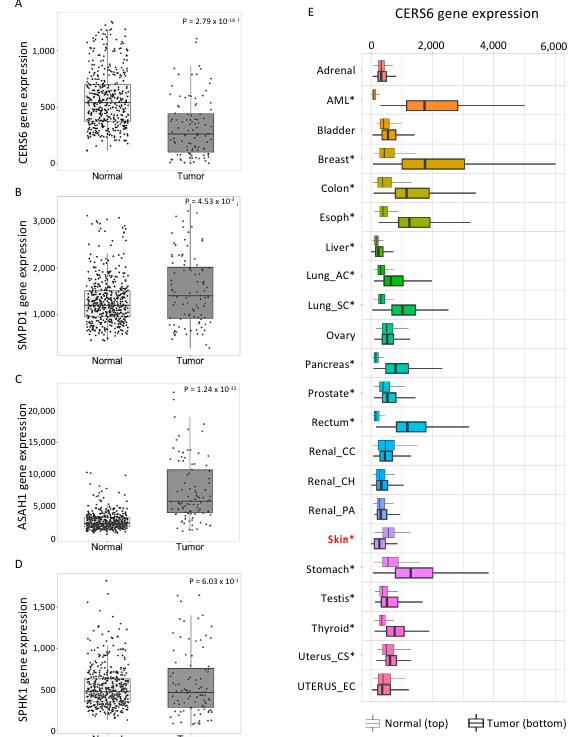
Figure 6. Ceramide metabolism enzyme expression is altered in human skin cancer. The web platform TNMplot was used to evaluate mRNA levels of ceramide metabolism enzymes in human non- cancerous normal skin tissue (normal, n = 474) and cutaneous melanoma (tumor, n = 103). ( A – D ) CERS6 ( A ), SMPD1 ( B ), ASAH1 ( C ), and SPHK1 ( D ) gene levels were analyzed between Normal and Tumor groups. ( E ) Pan-cancer analysis shows CERS6 gene expressions between Normal ( top ) and Tumor ( bottom ) in 22 cancer tissue types. Lung_AC, lung adenocarcinoma; Lung_SC, lung squa- mous cell carcinoma; Renal_CC, kidney renal clear cell carcinoma; Renal_CH, kidney chromophobe; Renal_PA, kidney renal papillary cell carcinoma; Uterus_CS, uterine carcinosarcoma; Uterus_EC, uterine corpus endometrial carcinoma. Significant differences were analyzed by Mann–Whitney U test and are denoted with an asterisk. * p < 0.01 vs. paired normal control. Font and color were mod- ified for better readability of the original graphs obtained from TNM plot.com. Skin cancer is marked with red for better visualization. 4. Discussion Identification of the molecular changes within tumors that are induced by exercise is critical to maximizing the potential of exercise as adjuvant therapy for the treatment of